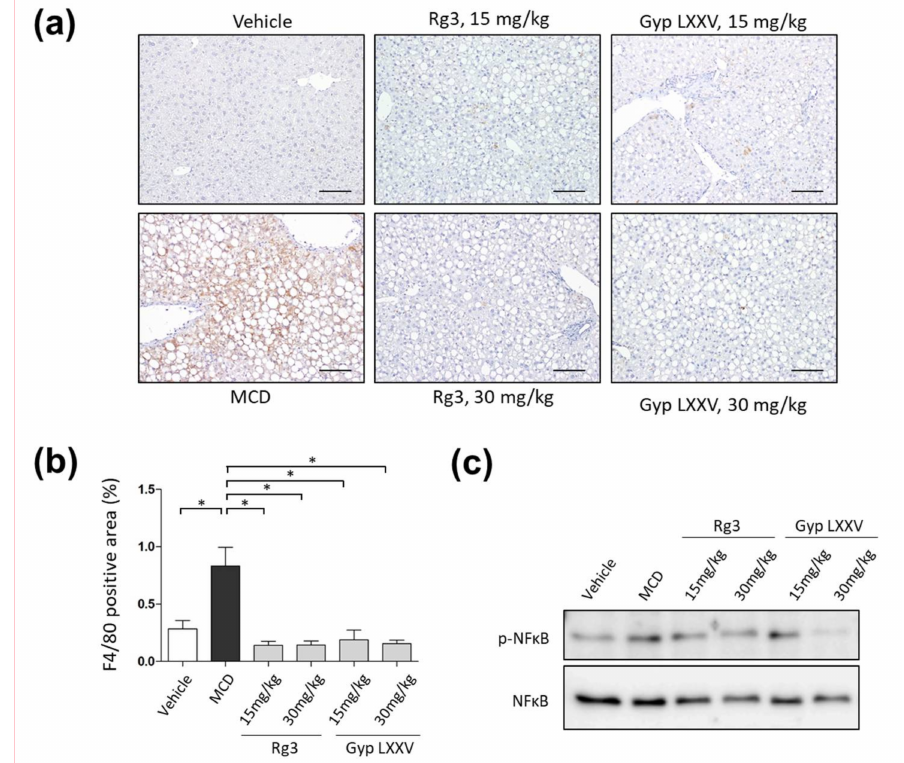
Figure 8. Inhibitory e ff ect of Gyp LXXV on hepatic macrophages in the MCD diet mouse model. Representative IHC staining for F4 / 80 in the liver ( a ). The distribution of intracellular hepatic macrophages in the MCD diet mouse model with or without Gyp LXXV or Rg3 was investigated. 200 × magnification, scale bar 100 µ m. Quantification of F4 / 80 positive cells in para ffi n sections of the liver ( b ). Error bar represent SEM. * p < 0.05 vs. MCD group, two tailed unpaired t-test. The protein levels of p-NF κ B and nuclear factor κ B (NF κ B) were determined by Western blot analysis ( c